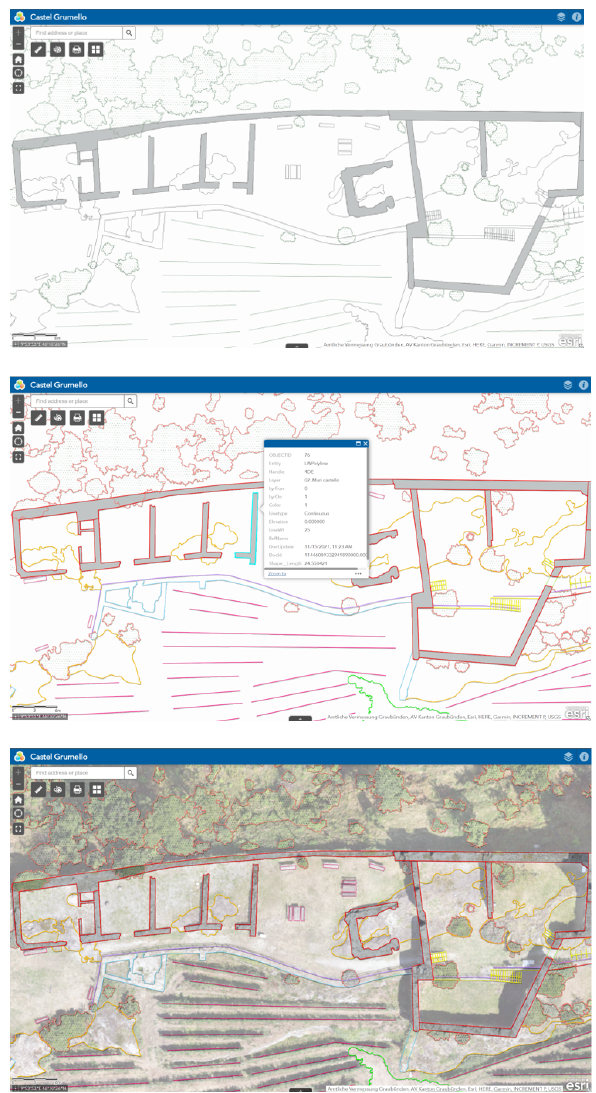
Figure 11: Examples of different datasets accessible using the GIS webapp.